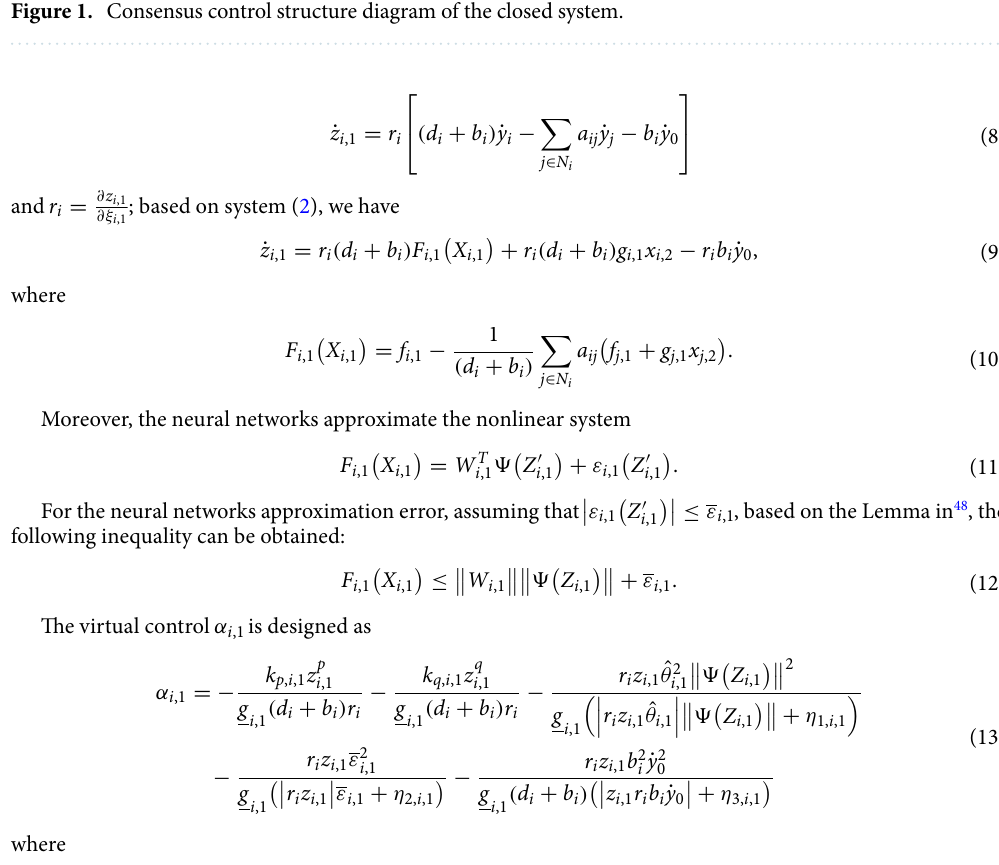
Figure 1. Consensus control structure diagram of the closed